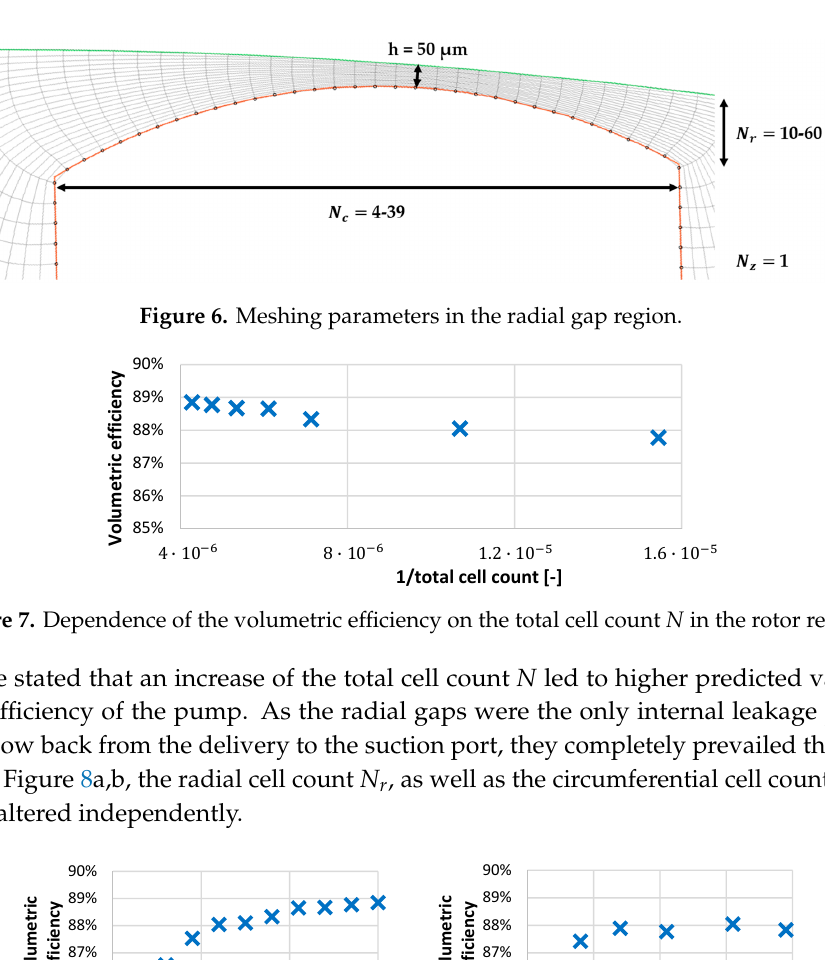
Figure 9. Influence of ( a ) (cid:1840) (cid:3045) at (cid:1840) (cid:3030) = 31 and ( b ) (cid:1840) (cid:3030) at (cid:1840) (cid:3045) = 24 on the instantaneous mass flow rate ripple at outlet 1.